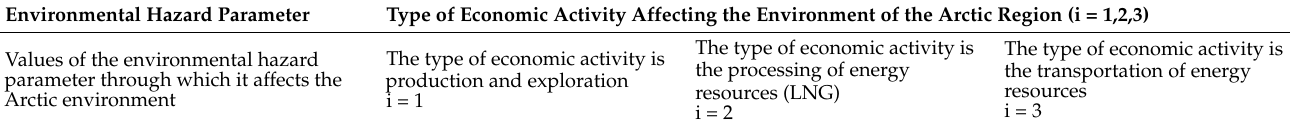
Table 3. Types of economic activities affecting the environment in the Arctic region